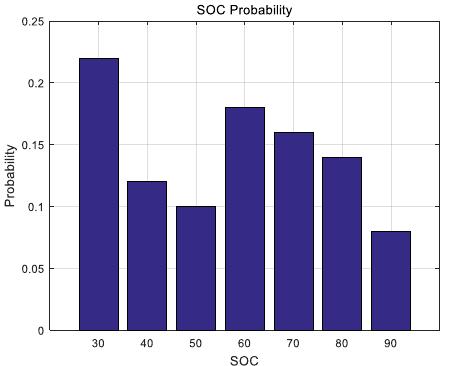
Figure 9. SOC Remaining Probability.